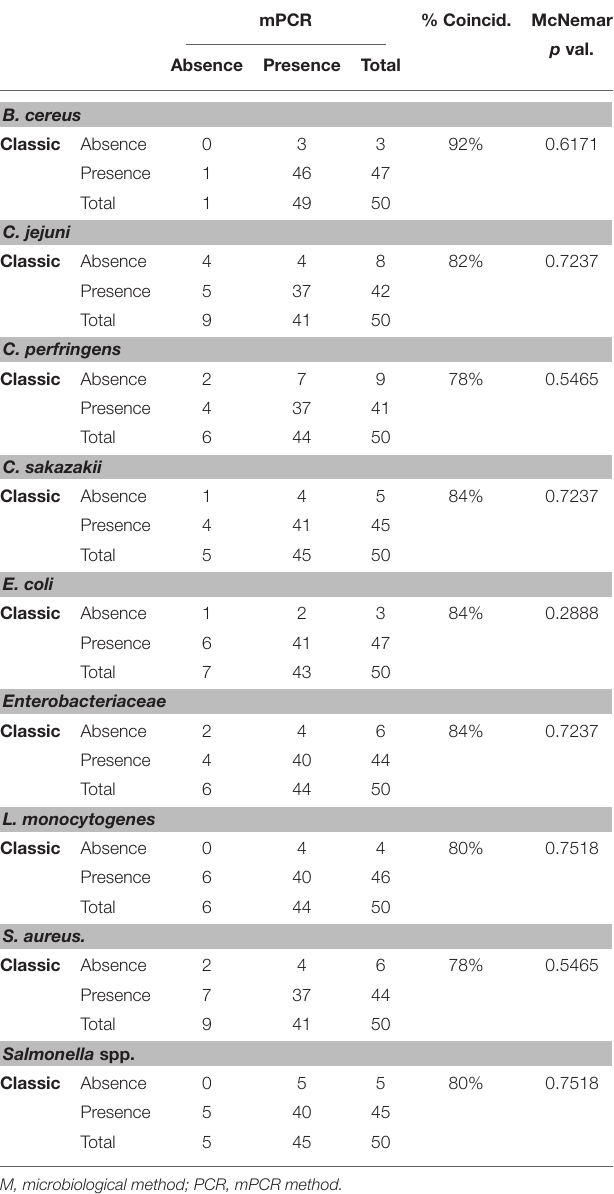
TABLE 5 | General contingency tables for nine microorganisms, showing percentage of coincidence and p -value for McNemar’s test. mPCR % Coincid.